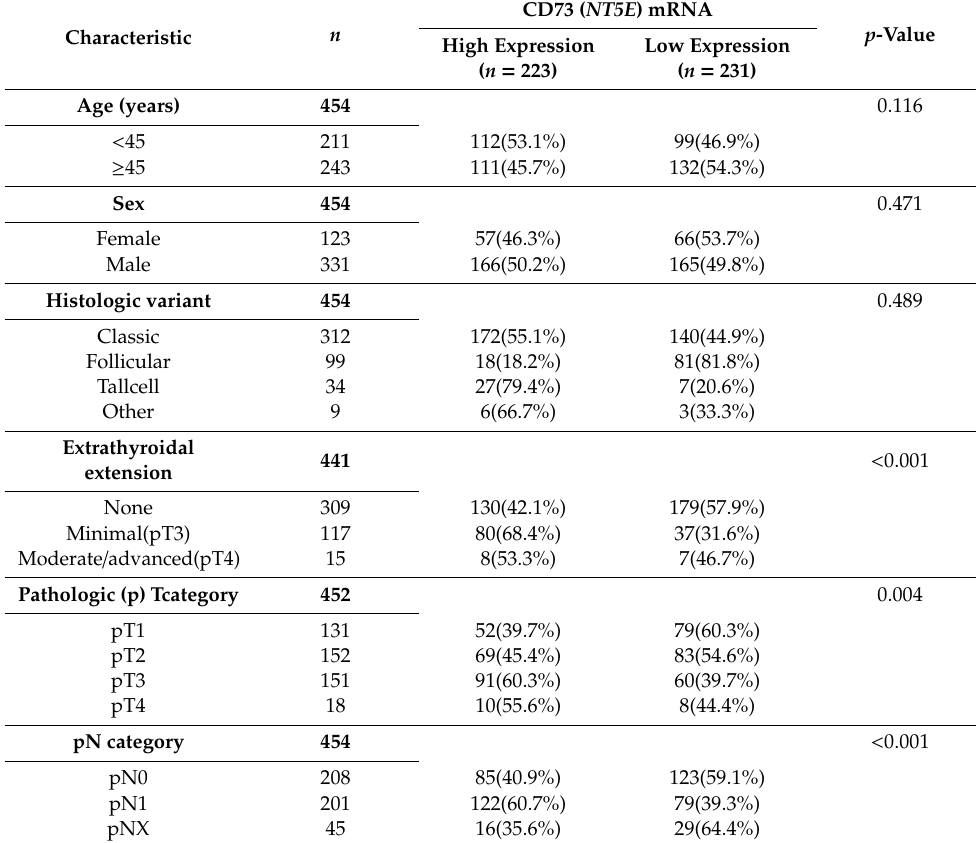
Table 3. Correlation between CD73 ( NT5E ) mRNA expression and clinicopathologic features of papillary thyroid carcinoma in The Cancer Genome Atlas (TCGA)